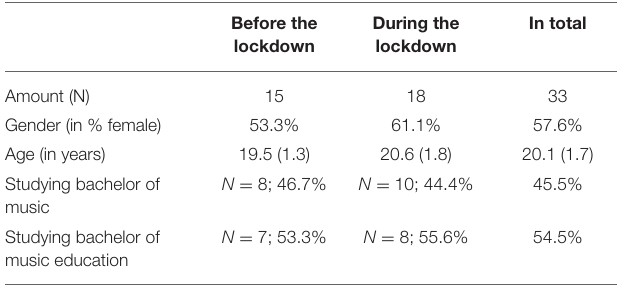
TABLE 1 | Distribution and characteristics of the sample by measuring times (brackets, standard